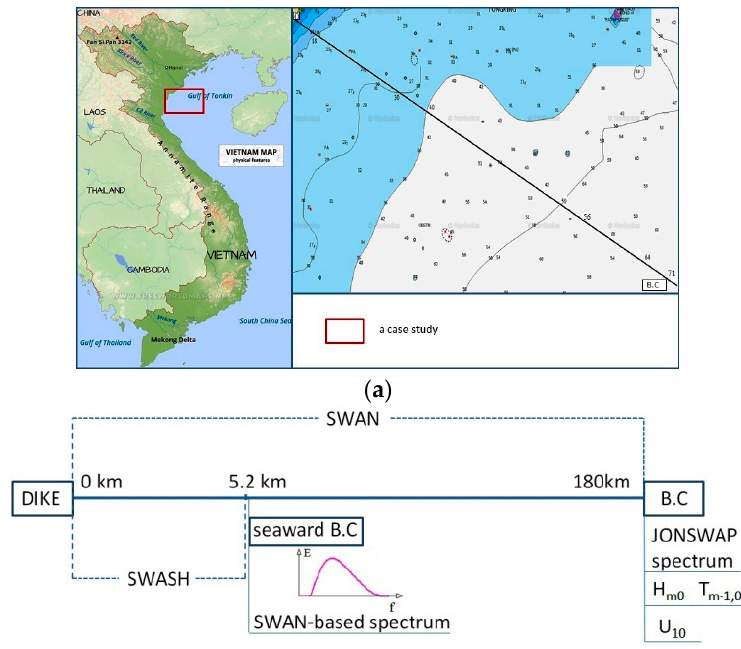
Figure 1. ( a ) A case study on the Vietnamese coastlines (top-left figure) and corresponding bathymetry (top-right figure), depths are indicated in meters. ( b ) Boundary conditions of SWAN and SWASH models (bottom